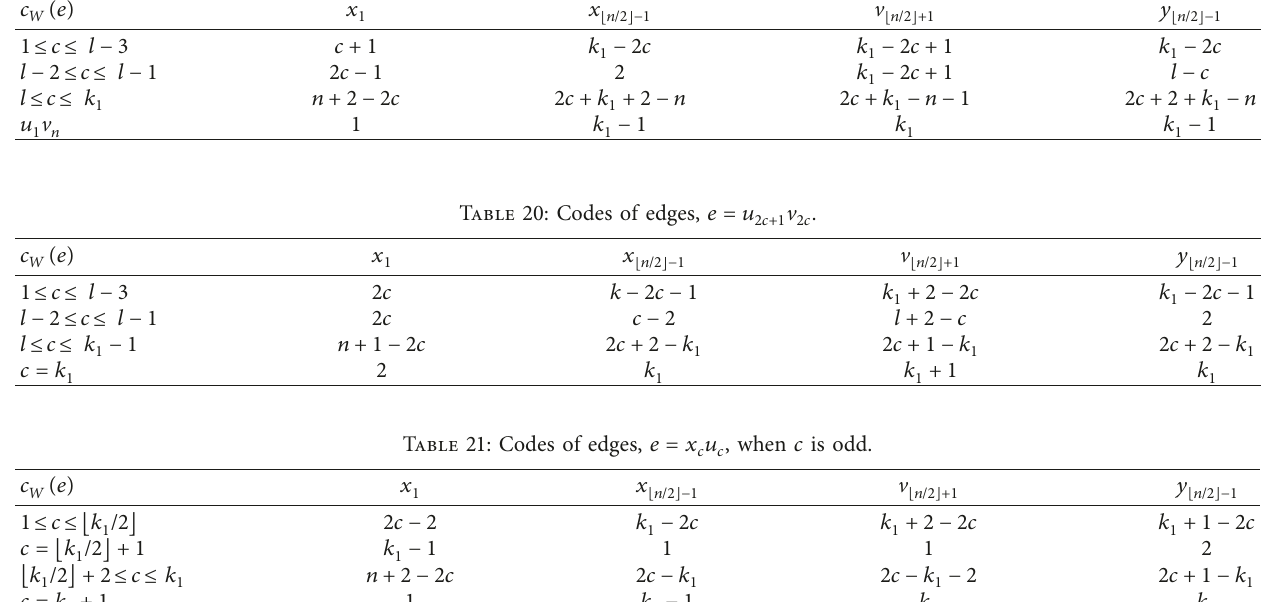
Table 19: Codes of edges, e � u